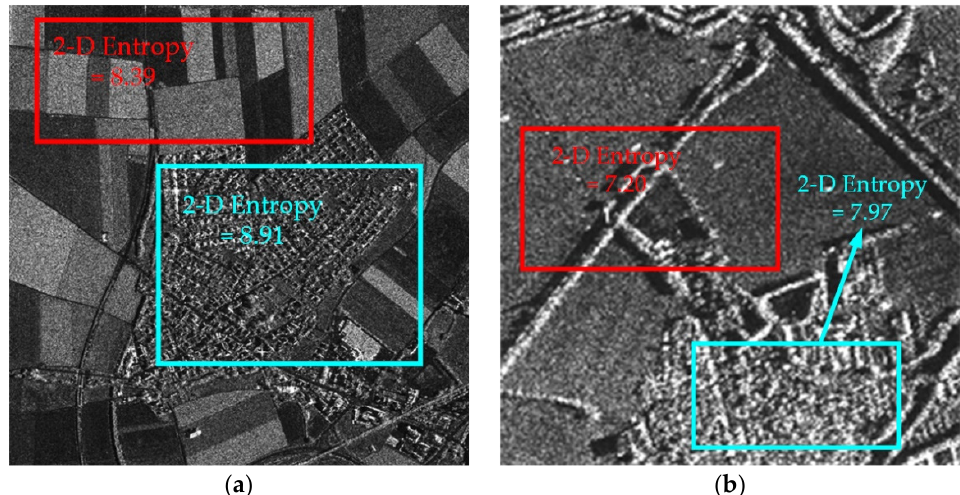
Figure 5. Different entropy values for different regions. Both ( a ) and ( b ) show the 2-D entropy of scenes with different complexity.